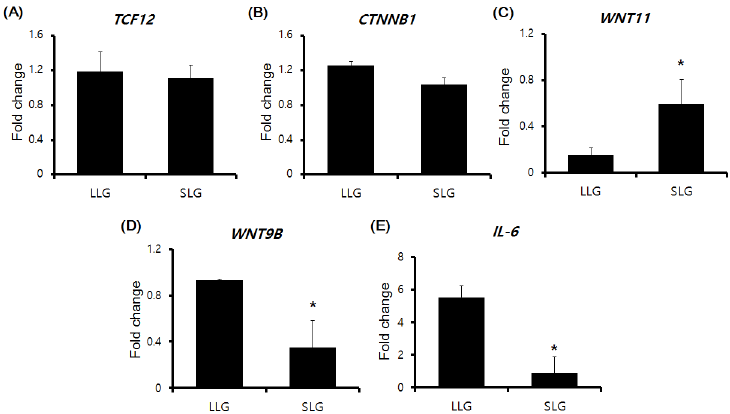
Fig 5. RT-qPCR analysis to assess TCF12 , CTNNB1 , WNT11 , WNT9B and IL-6 mRNA expression. RNAs from three different individual placentas each were prepared from LLG and SLG. RT-qPCR was performed using gene-specific primers. PPIA was used as a universal control. The RT-qPCR data were analyzed by relative quantification using 2 - ΔΔ Ct . Data are expressed as means ± standard deviation (S.D.). Each experiment was performed in triplicate. * , p < 0.05 versus